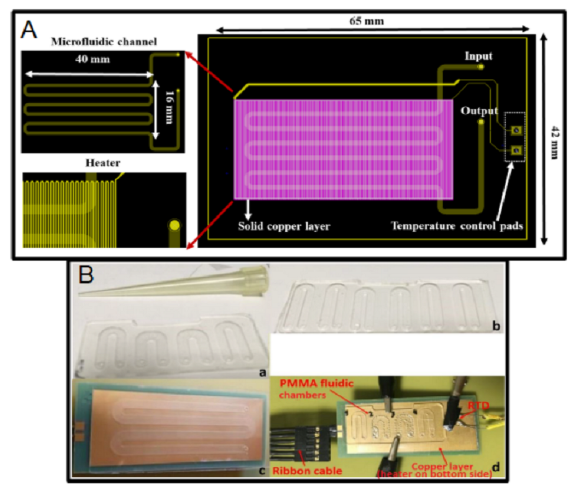
Figure 15. ( A ) Recombinase Polymerase Amplification (RPA)-on-PCB chip design for DNA am- plification. The meandering microfluidic channel, the microheater with its electrical pads, and a solid copper layer beneath the microchannel for optimum temperature uniformity are depicted (reprinted from [25], copyright (2021), Creative Commons License). ( B ) a: Poly(methyl methacry-